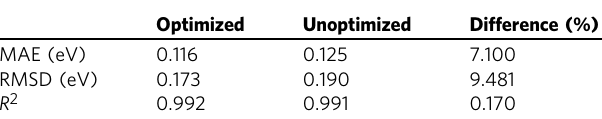
Table 1 Comparison of performance on relaxed and unrelaxed surfaces.